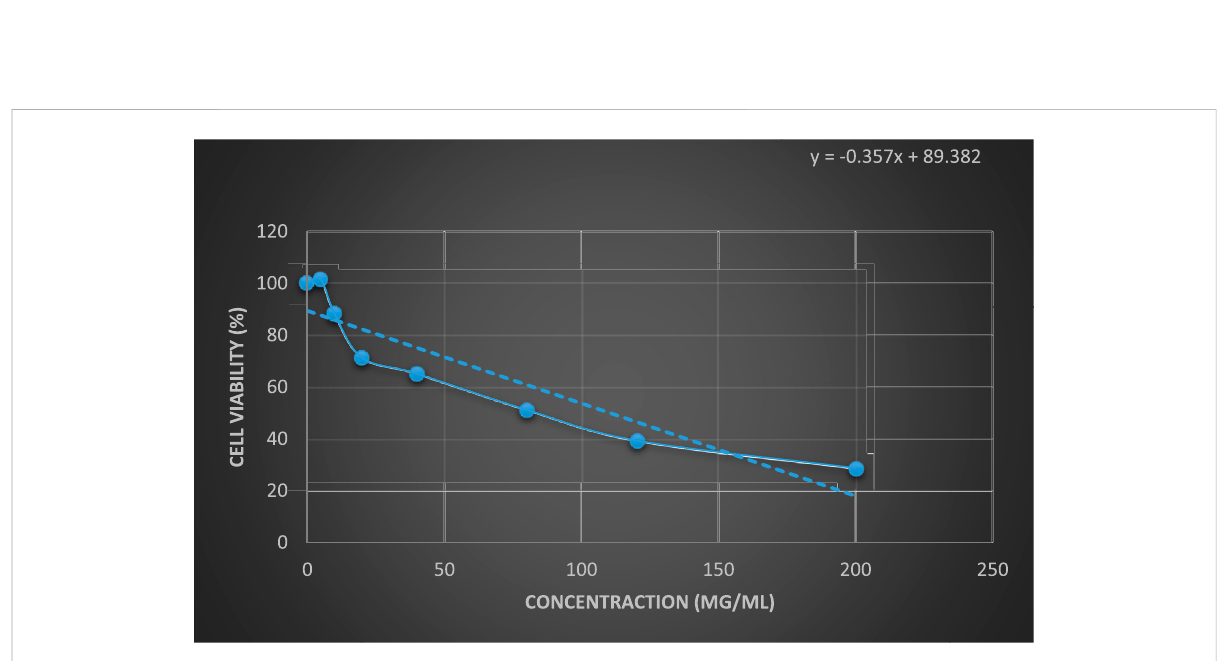
FIGURE 9 Anticancer activity of CCPSF NPs against MCF-7 breast cancer cells at 48 h. Data represented mean ( n = 3) ±